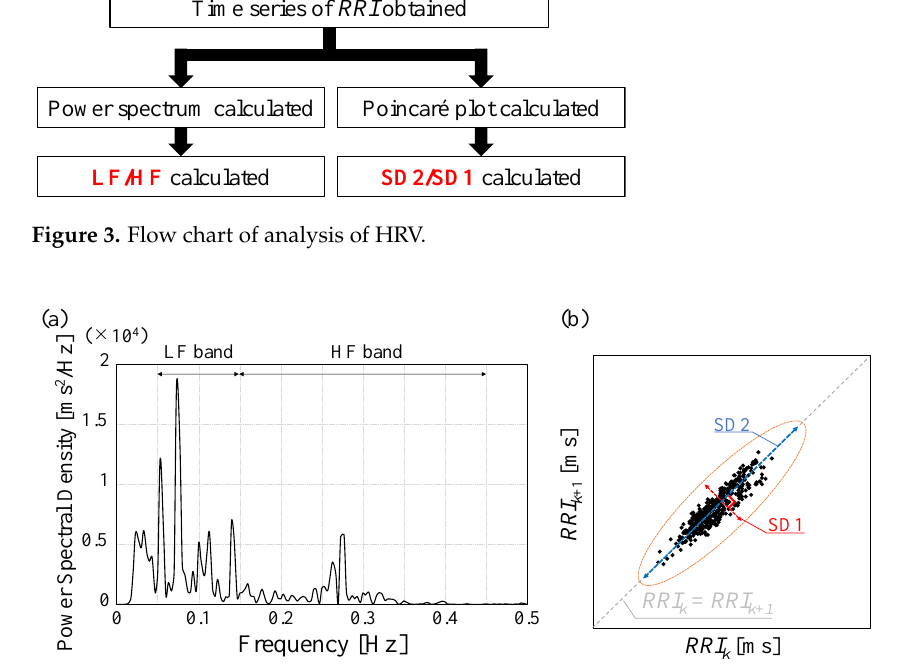
Figure 4. Examples of ( a ) power spectral density and ( b ) Poincar é plot,